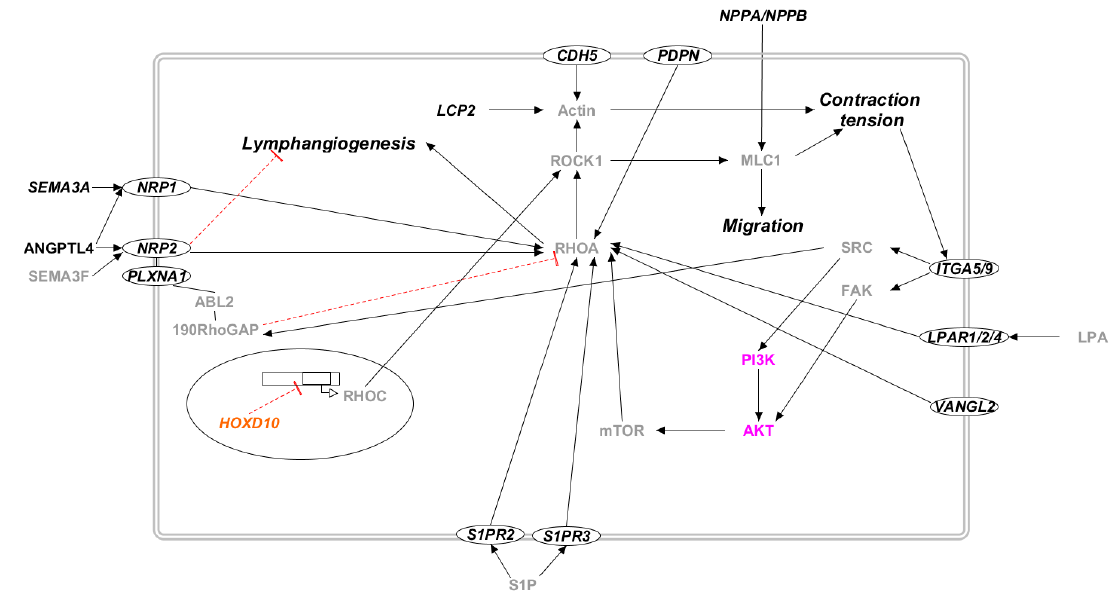
Figure 5. The Rho/ROCK pathway in candidate genes for primary lymphedema. Proteins that participate in PI3K/AKT molecular pathway are colored in lilac. The transcription factors are marked in orange. Proteins that do not participate in any of the previously reported pathways are marked in black. Proteins not encoded by either diagnostic or candidate genes are marked in grey. Proteins encoded by candidate genes are reported in italic. When circled, the protein is a membrane protein. Black arrows represent a positive interaction, while red T-bars represent an inhibition.